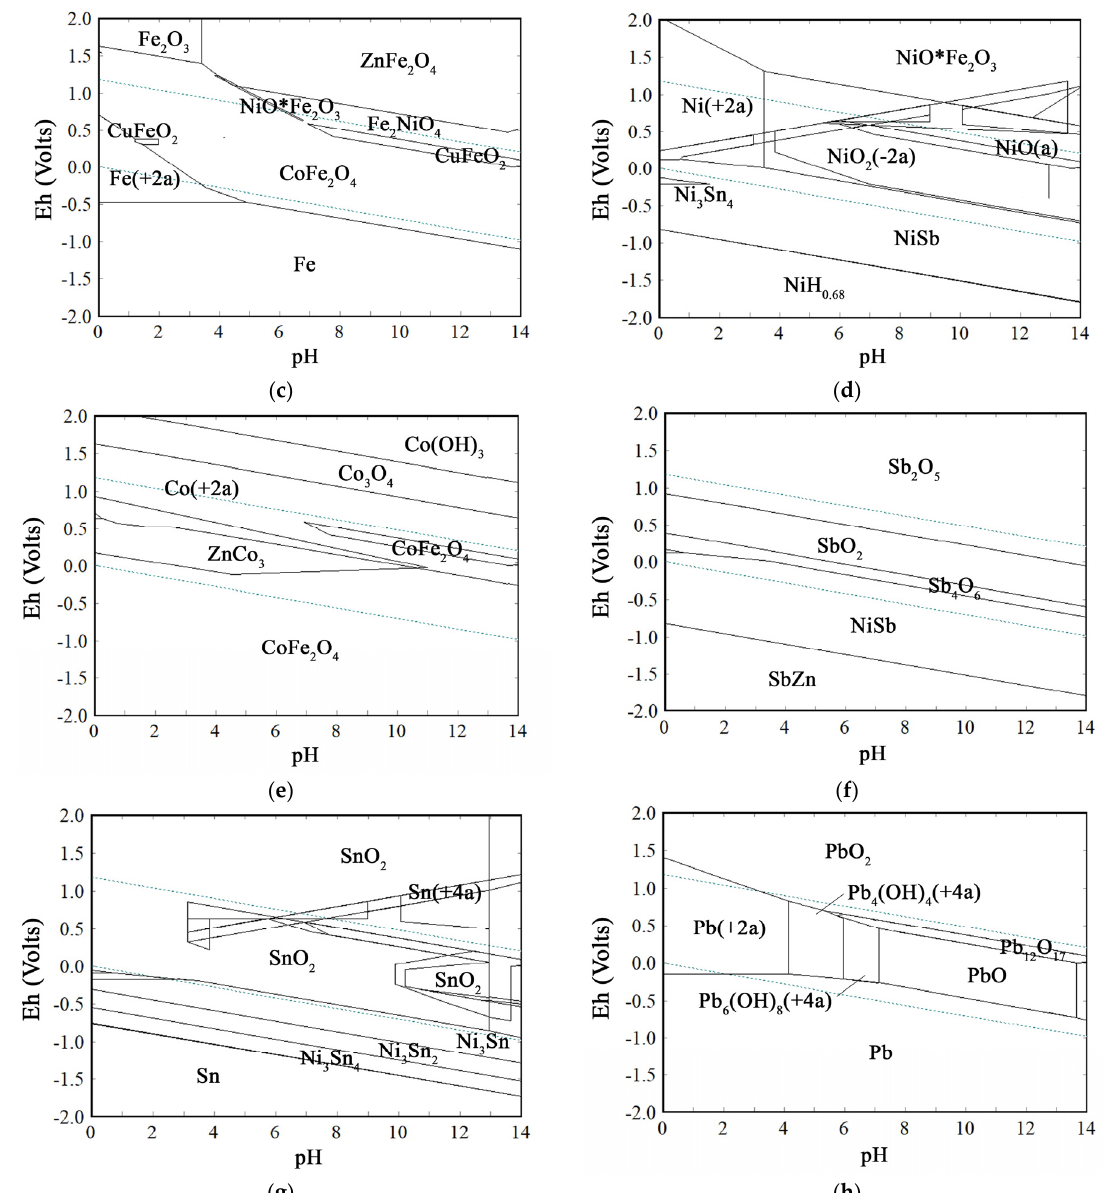
Figure 2. Pourbaix diagrams (Eh ‐ pH) for 1 mol/dm 3 (metal)/kg H 2 O and P θ : ( a ) Cu; ( b ) Zn; ( c ) Fe; ( d ) Ni; ( e ) Co; ( f ) Sb; ( g ) Sn and ( h ) Pb.